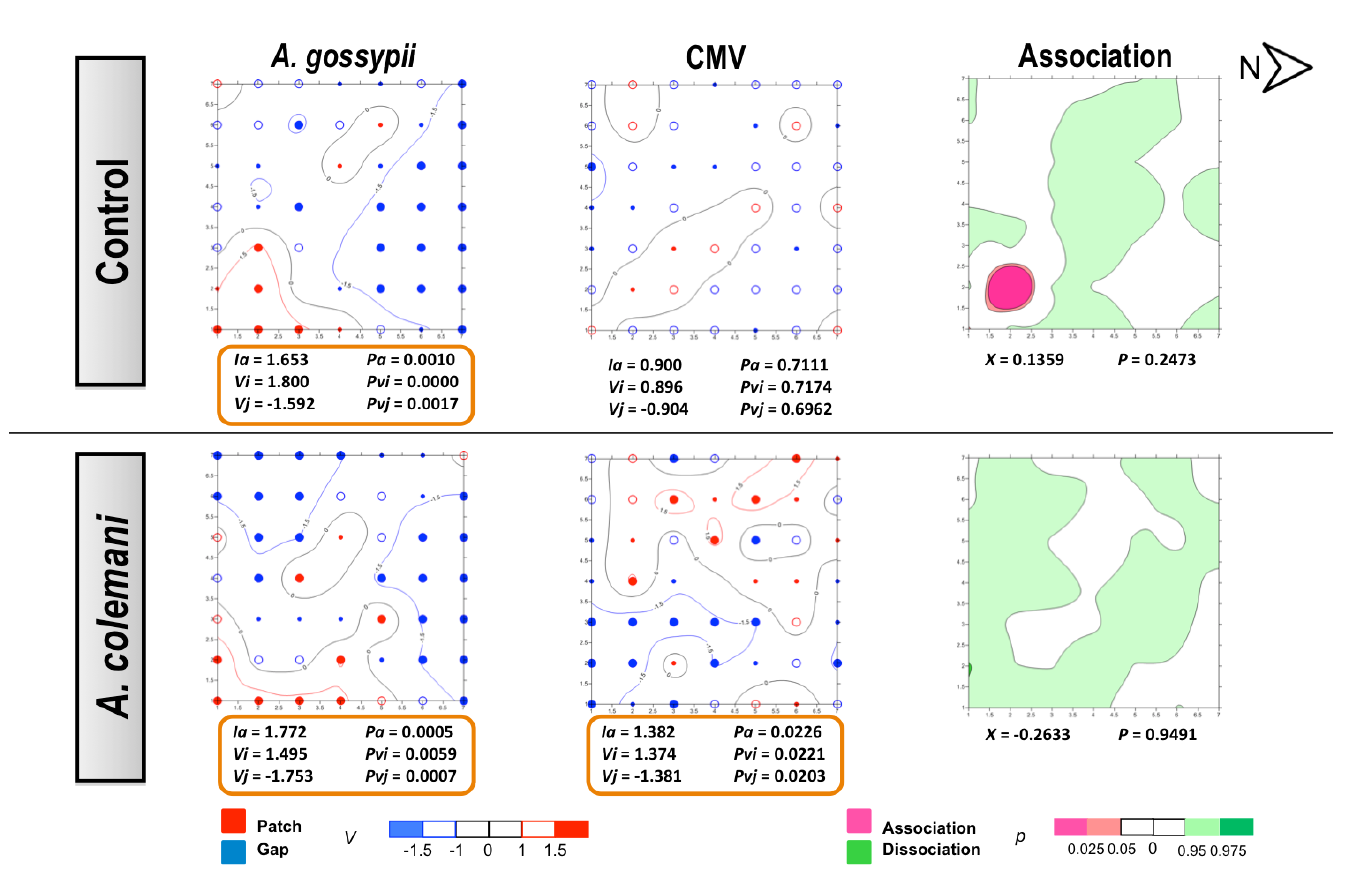
Figure 3. Classed post maps of the spatial distribution of mean number of A. gossypii and cumulative number of CMV-infected plants (total number of infected plants per treatment) at 2 days, and contoured map of the association between CMV-infected plants and its vector, A. gossypii . Spots indicate individual test plants. Small filled spots represent clustering indices of 0 to ± 0.99 (clustering below expectation), unfilled spots ± 1 to ± 1.49 (clustering slightly exceeds expectation) and large filled spots >1.5 or <1.5 (more than half as much as expectation). Red lines enclosing patch clusters are contours of v = 1.5 and blue lines are of v = –1.5. Black lines are zero-value contours, representing boundaries between patch and gap regions. The index of aggregation, Ia , the positive patch cluster index, vi , the negative gap cluster index, vj , and the index of spatial association, X , enclosed by an orange line are statistically significant. Letter N and arrow indicate north